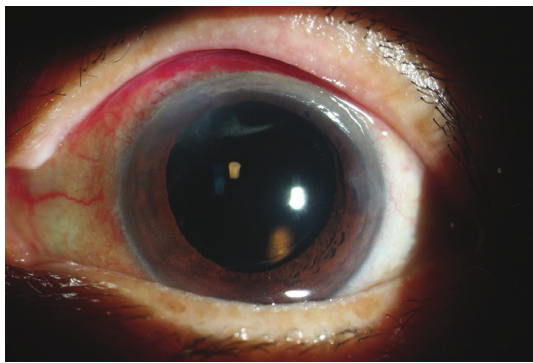
Figure 3: Postoperative image of the same patient as that in Figure 2.